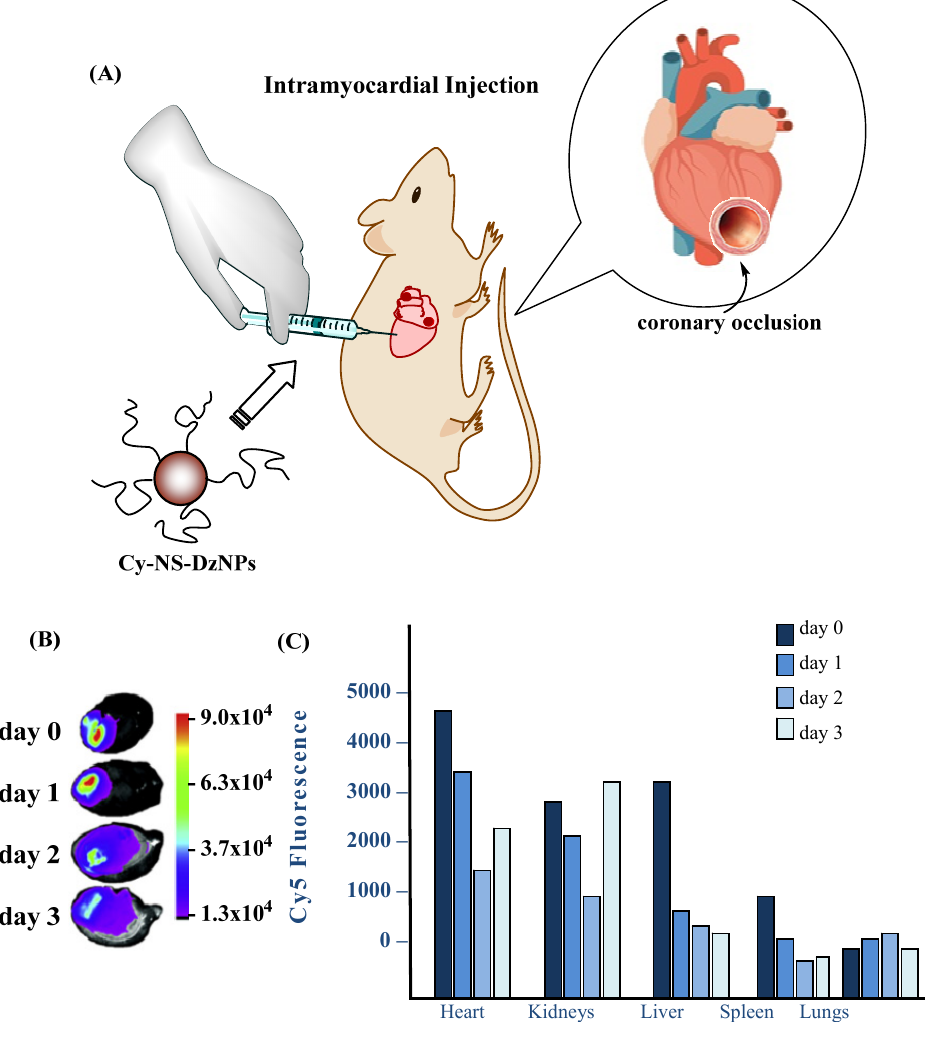
Figure 5. Ex-vivo fluorescence imaging of organs from animals injected with Cyanine 5-Non-Specific (Cy5-NS)-deoxyribozyme Nanoparticles (DzNP). ( A ) Schematic of ligation of the coronary artery to cause permanent ligation MI in rats followed by particle injection. ( B ) Fluorescence images of hearts from each day following injection. The heat map indicates the Cy5 emission intensity in arbitrary units. ( C ) Fluorescence intensity of all organs imaged from days 0, 1, 2 and 3. The Cy5 fluorescence intensity is expressed in arbitrary units. A total of four rats were used where each time point consists of fluorescence from an individual rat. Adapted from [65], NRC, 2018.